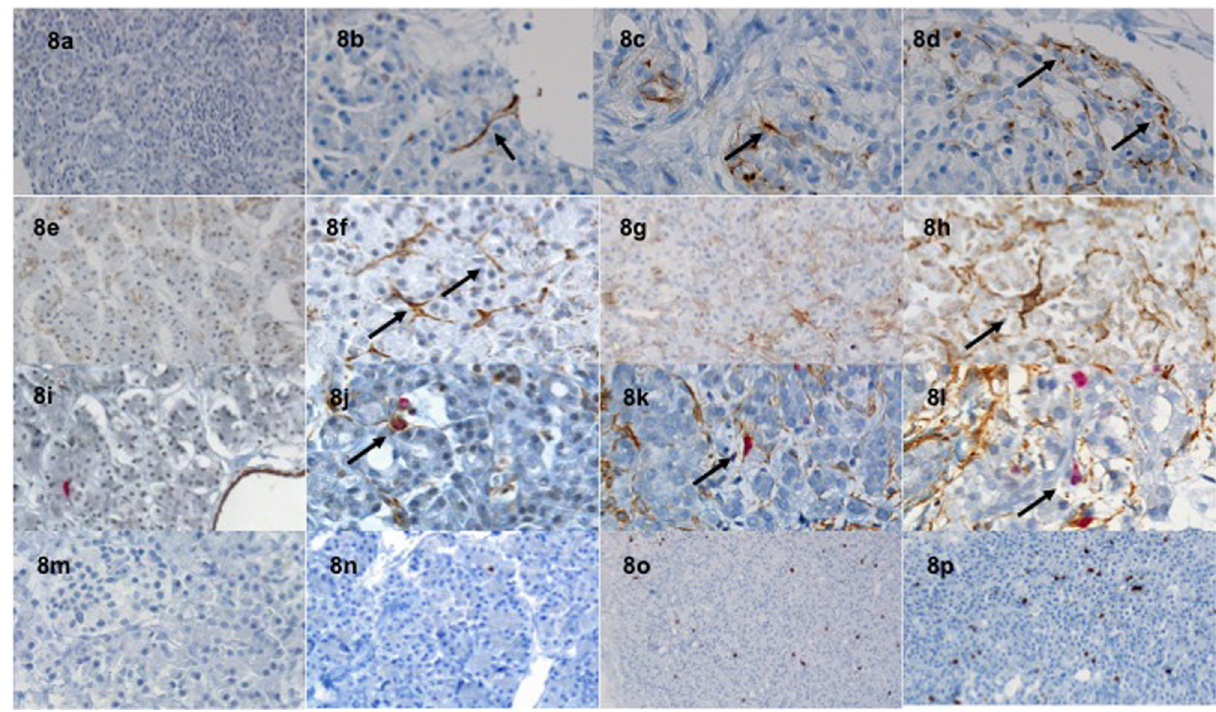
Figure 8. Nestin expression of PSC (black arrows) at baseline (8a), H24 (8b), H48 (8c) and H72 (8d). Smooth muscle actin expression of PSC (black arrows) at baseline (8e), H24 (8f), H48 (8g) and H72 (8h). Double Ki67/α-SMA expression of PSC was performed. The nuclear Ki67 and the cytoplasmic α-SMA expression (black arrows) appeared as red and brown immunostaining, respectively (baseline, 8i; H24, 8j; H48, 8 k and H72, 8l). The Ki67 nuclear staining of PSC was observed (baseline, 8m; H24, 8o; H48, 8p and H72, 8q).